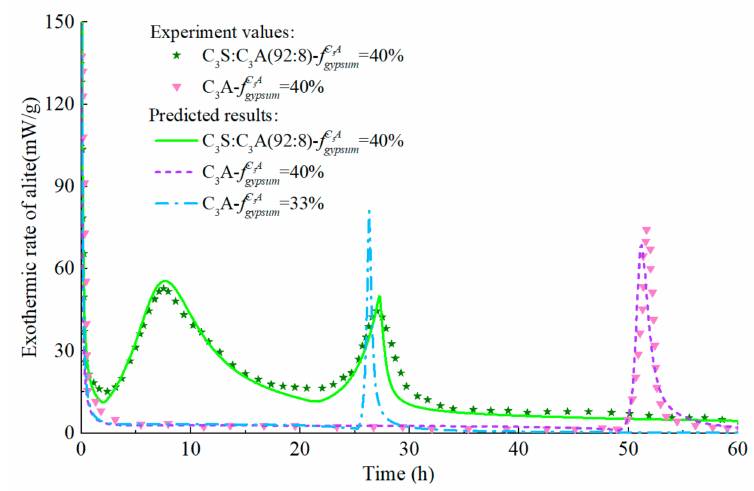
Figure 21. Heat release rate of C 3 A-Alite-gypsum system and alite-gypsum system (w/c = 0.4).